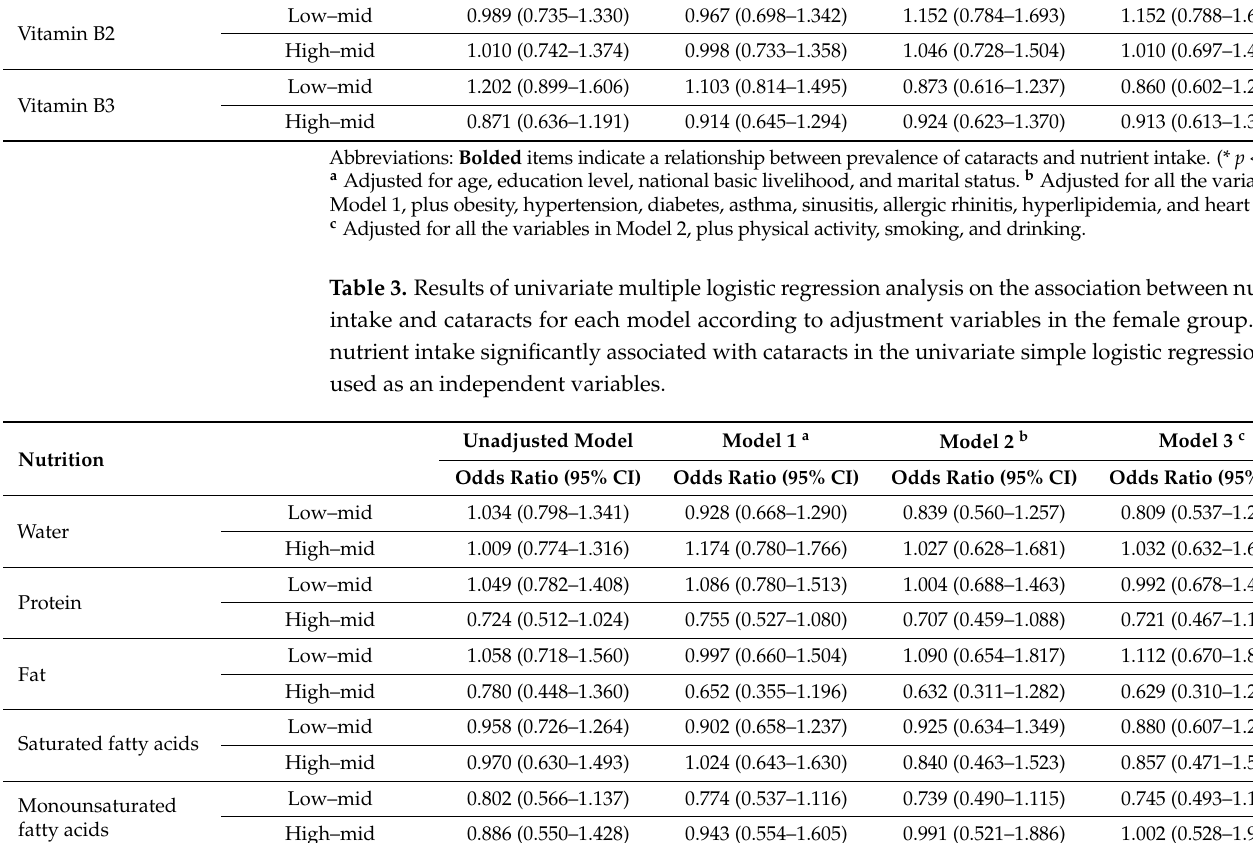
Abbreviations: Bolded items indicate a relationship between prevalence of cataracts and nutrient intake. (* p < 0.05 ). a Adjusted for age, education level, national basic livelihood, and marital status. b Adjusted for all the variables in